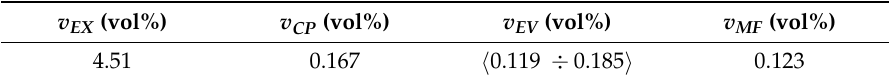
Table 3. Volumetric content of graphene nanoplatelets in RTV/GNP composite corresponding to the onset of conductivity: v EX = critical fraction observed during experiment, v CP = percolation threshold according to classical percolation equation [28], v EV = percolation threshold range in excluded volume approach [30], v MF = percolation threshold derived from mean field theory [31].